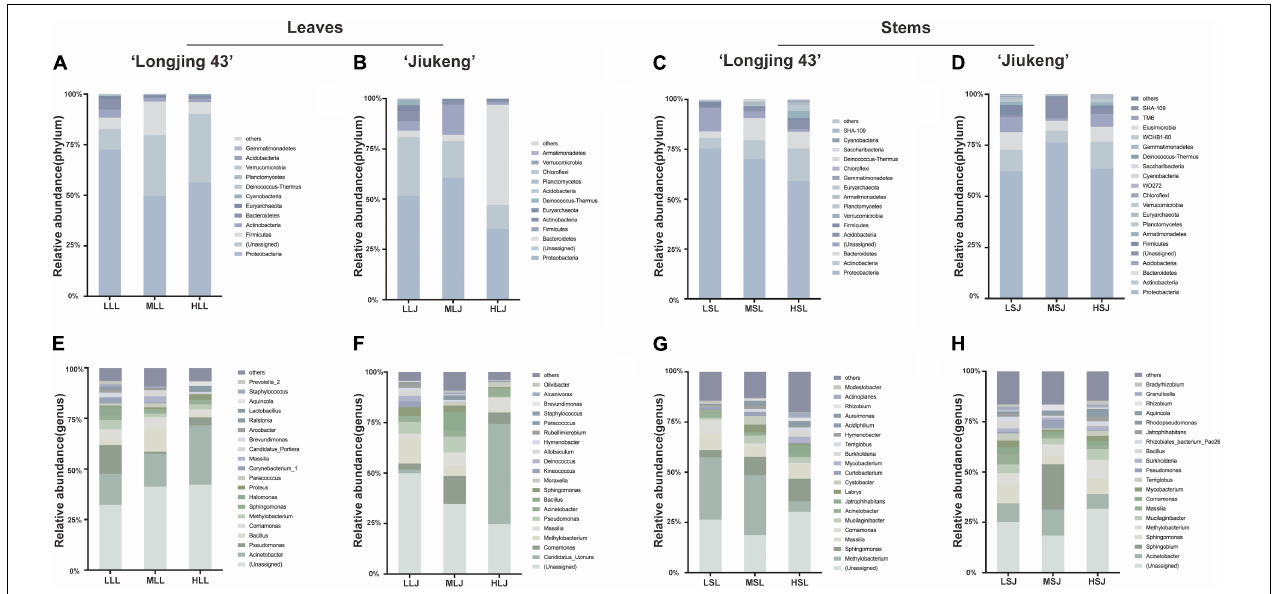
FIGURE 4 | Effects of sterilization treatments on the composition of bacterial endophytes from tea plant leaves and stems at the phylum level (A–D) and genus level (E–H) . LLL, MLL, and HLL represent the leaf samples from the cultivar Longjing 43 treated with 0.5, 1.0, and 2.0% of NaClO. LLJ, MLJ, and HLJ represent the leaf samples from the cultivar Jiukeng treated with 0.5, 1.0, and 2.0% of NaClO. LSL, MSL, and HSL represent the stem samples from the cultivar Longjing 43 treated with 0.5, 1.0, and 2.0% NaClO. LSJ, MSJ, and HSJ represent the leaf samples from the cultivar Jiukeng treated with 0.5, 1.0, and 2.0%